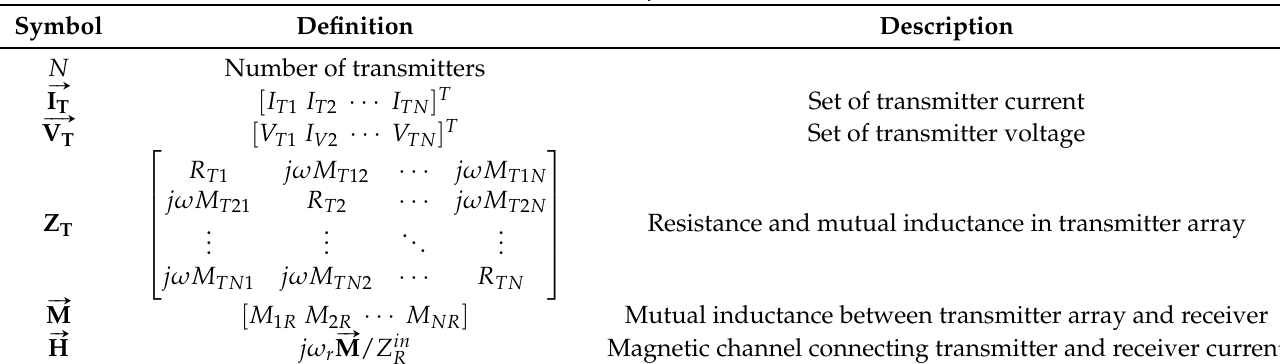
Table 1. Vector and matrix denotations for